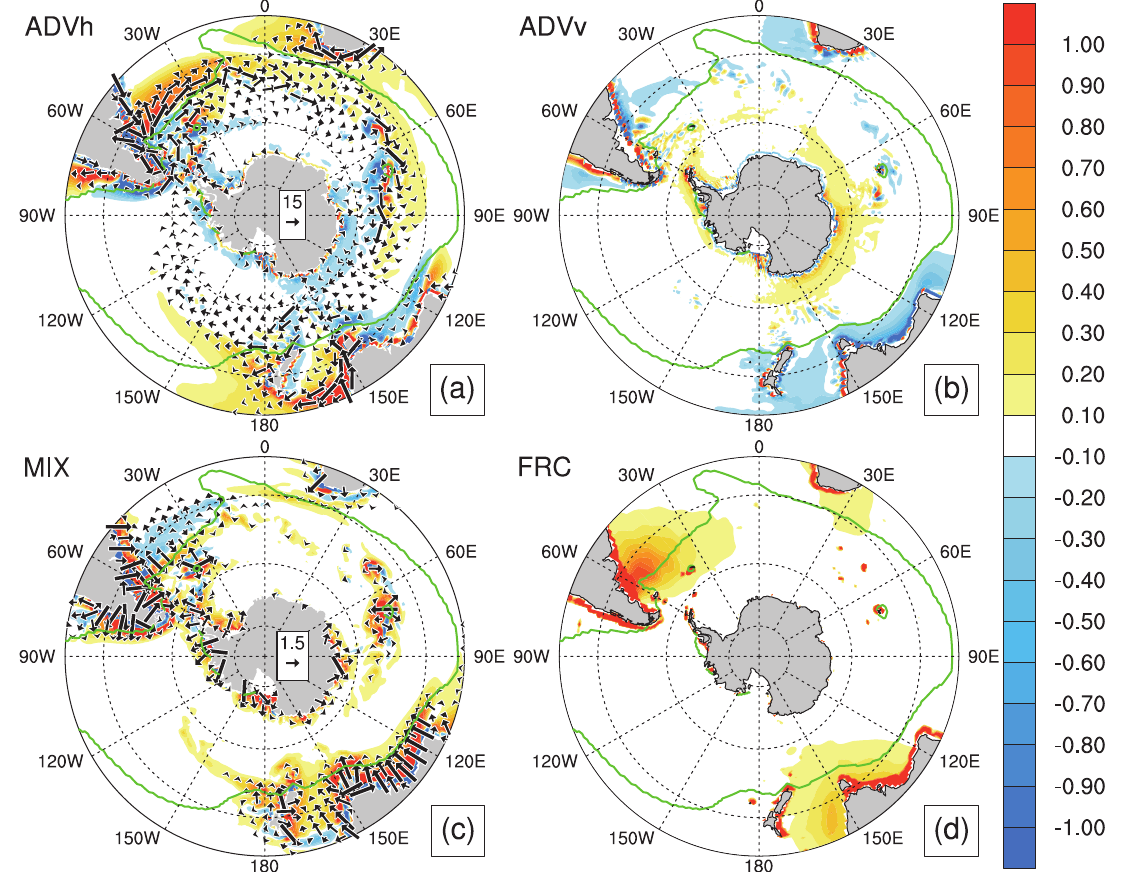
Fig. 10. Spatial distributions of the annual mean dissolved iron tendency (color scale, µmolm − 3 yr − 1 ) averaged over the upper 100m: (a) ADVh, (b) ADVv, (c) MIX, and (d) FRC. Vectors represent the horizontal iron flux averaged over the upper 100m (µmolm − 3 yr − 1 ) . The maximum advection (mixing) vector length is set to 30µmolm − 3 yr − 1 (3µmolm − 3 yr − 1 ) , and advection (mixing) vectors with magnitudes of less than 3µmolm − 3 yr − 1 (0.3µmolm − 3 yr − 1 ) are omitted. The green line represents the border of the simulated HNLC region in the 1990s. Dotted concentric circles are the 80, 60, and 40 ◦ S